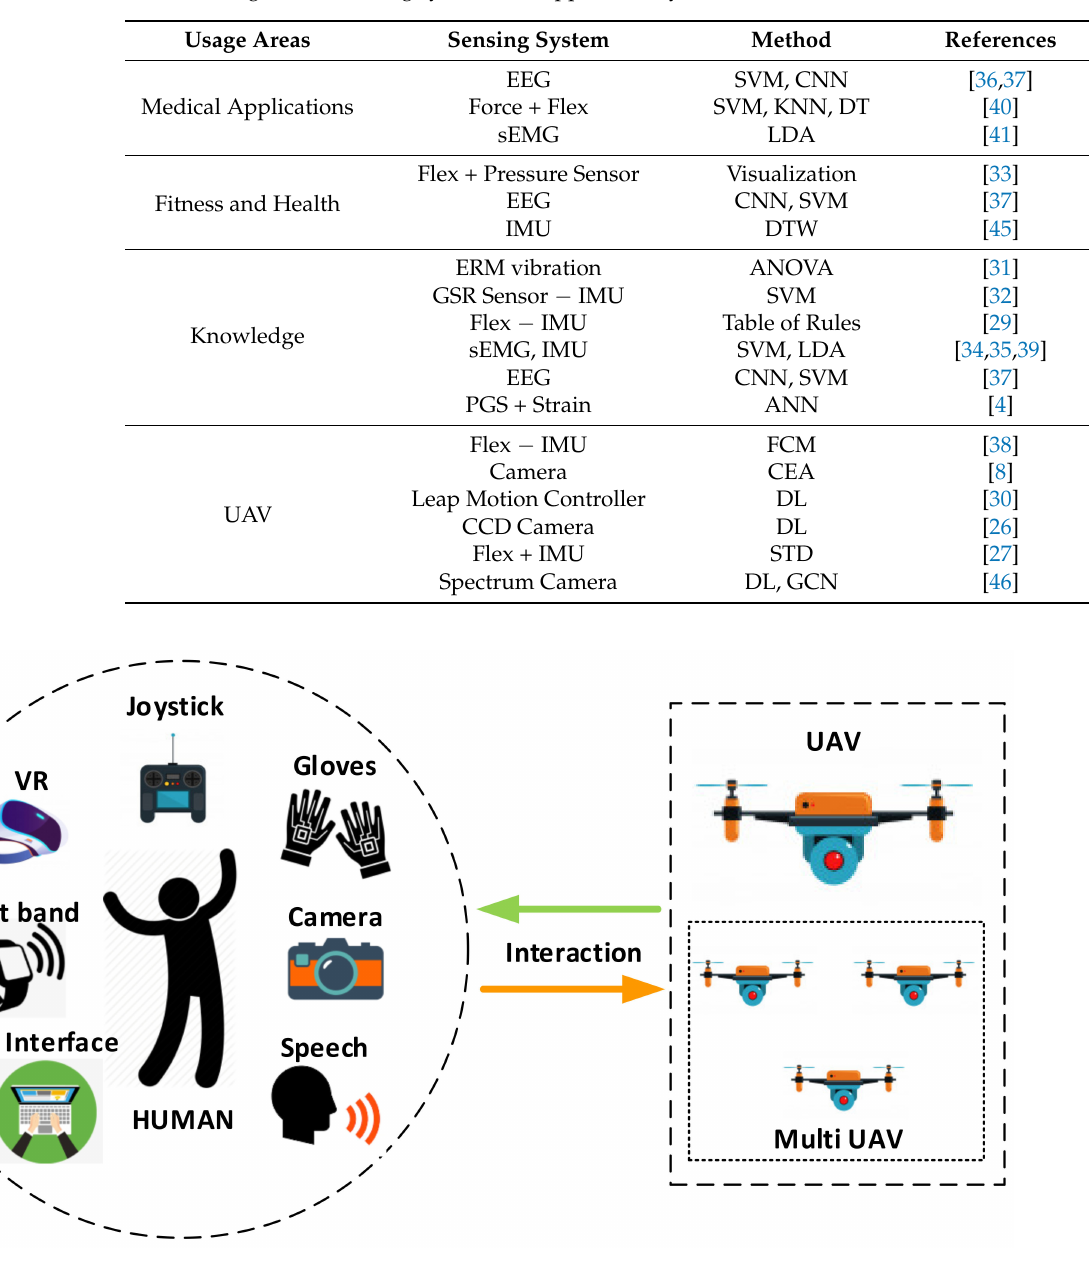
Figure 1. Methods used for UAV control in single or multiple human–UAV